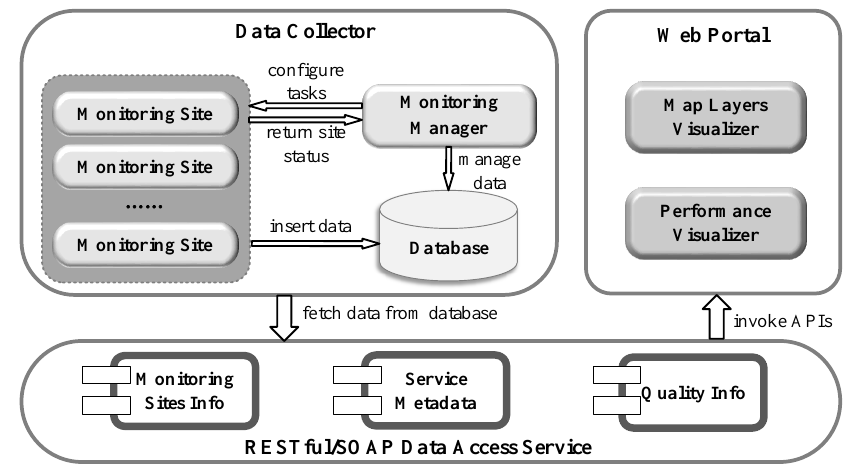
Figure 3. The architecture of the monitoring framework.